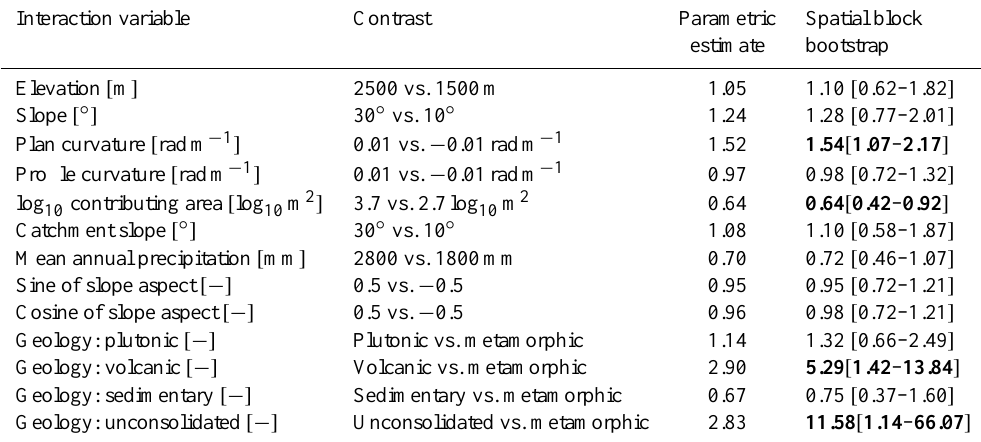
Table 4. Dependence of the GAM-derived odds ratio of landslide occurrence near versus distant from highway (200m versus 25m) on other predictors, expressed as the ratio of odds ratios (with 95% bootstrap confidence intervals). As an example, the odds ratio expressing the highway effect is 52% greater at a plan curvature of 0.01 compared to a plan curvature of − 0.01radm − 1 , based on parametric estimation. Estimates whose confidence intervals do not contain the ratio of 1 are printed in